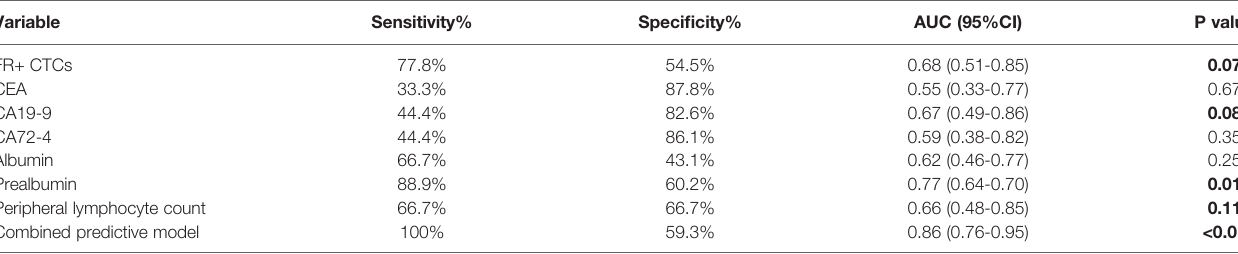
TABLE 3 | Diagnostic values of FR+ CTCs and other biomarkers risk factors for peritoneal metastasis.